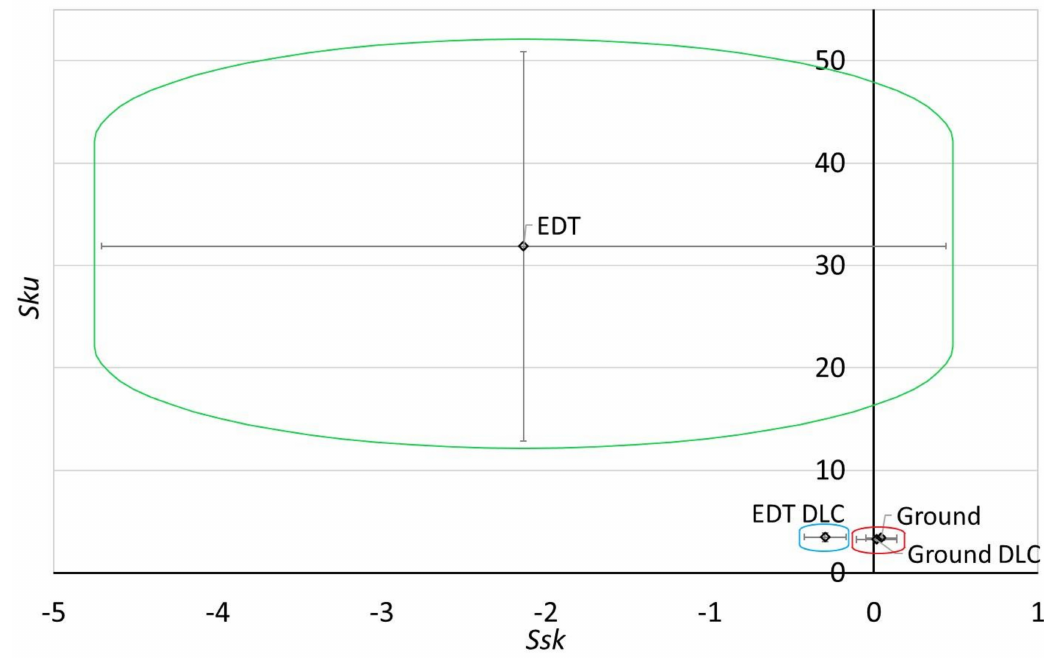
Figure 5. Morphological space Ssk versus Sku .